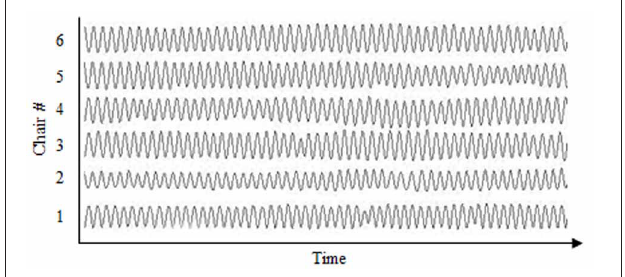
FIGURE 2 | Continuous group synchrony, ρ group , i averaged across group and